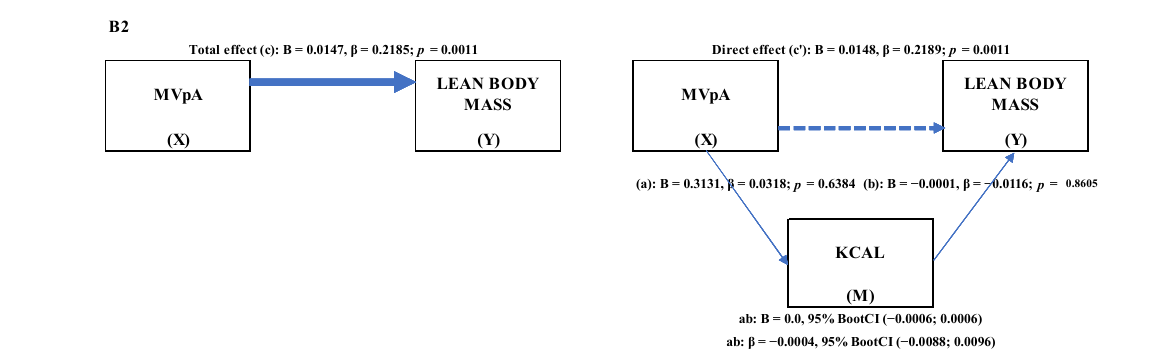
Figure 2. Mediation model A showing the effects (total, direct, and indirect) of MVPA on body composition variables. Mediation model B showing the effects (total, direct, and indirect) of MVPA on body composition variables. Abbreviations: MVPA, moderate-to-vigorous physical activity; IE L − 1, Intermittent Endurance Test level